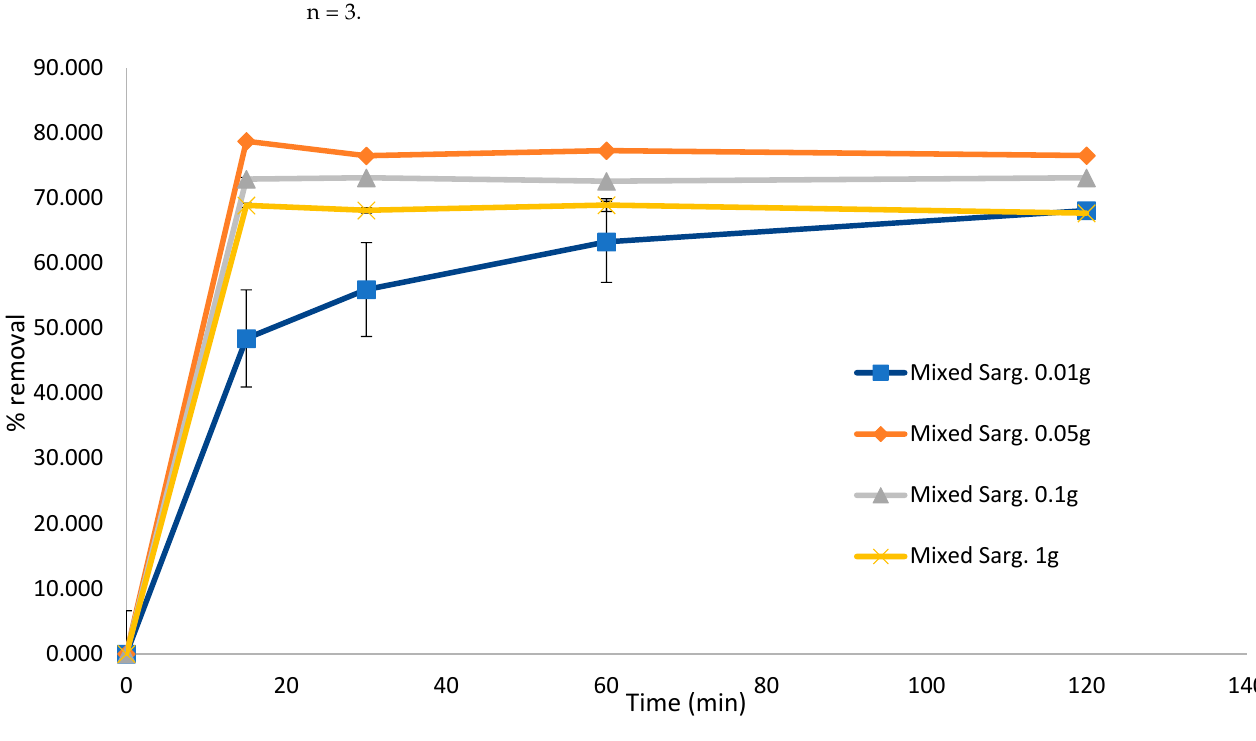
Figure 4. Biosorption of methylene blue over 120 min using Sargassum muticum (SM) at different concentrations. Concentration of dye remained constant at 10 mg L − 1 (80 mL). Standard deviation n = 3.